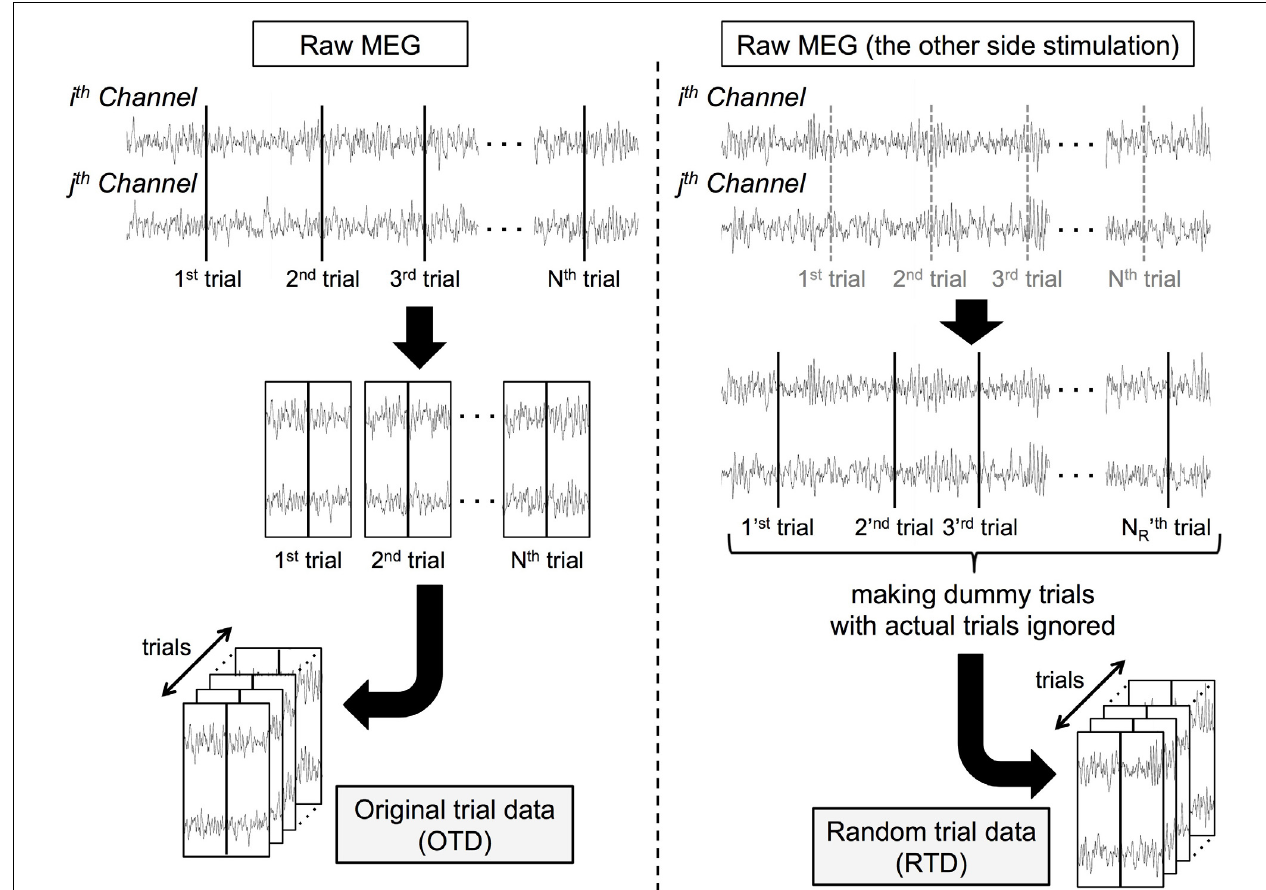
FIGURE 1 | Processing pipeline for constructing surrogate data. Each “trial K” and “trial K R ” represents Kth actual trial onset (K = 1,2, ..., N) and K R th dummy trial onset (K R = 1,2, ..., N R ). c-SI Ch: one of a channel pair over the primary somatosensory cortex contralateral to the stimuli, i-SII Ch: the other of a channel pair over the secondary somatosensory cortex ipsilateral to the